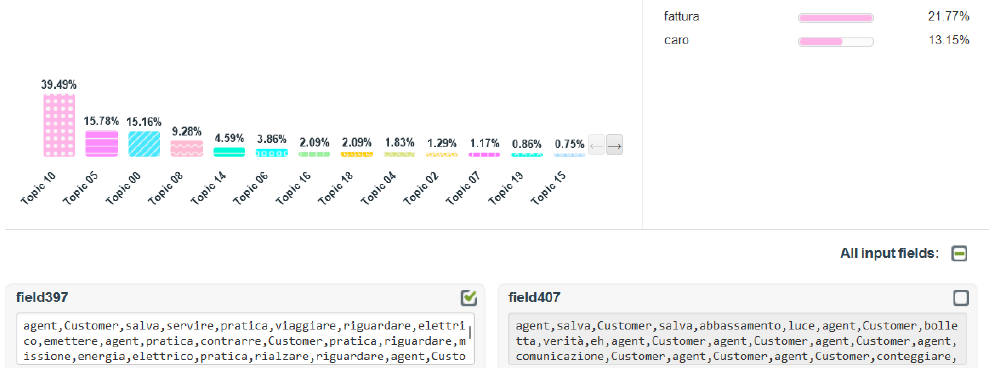
Figure 9. Topic Distribution for transcription no. 397, with k =